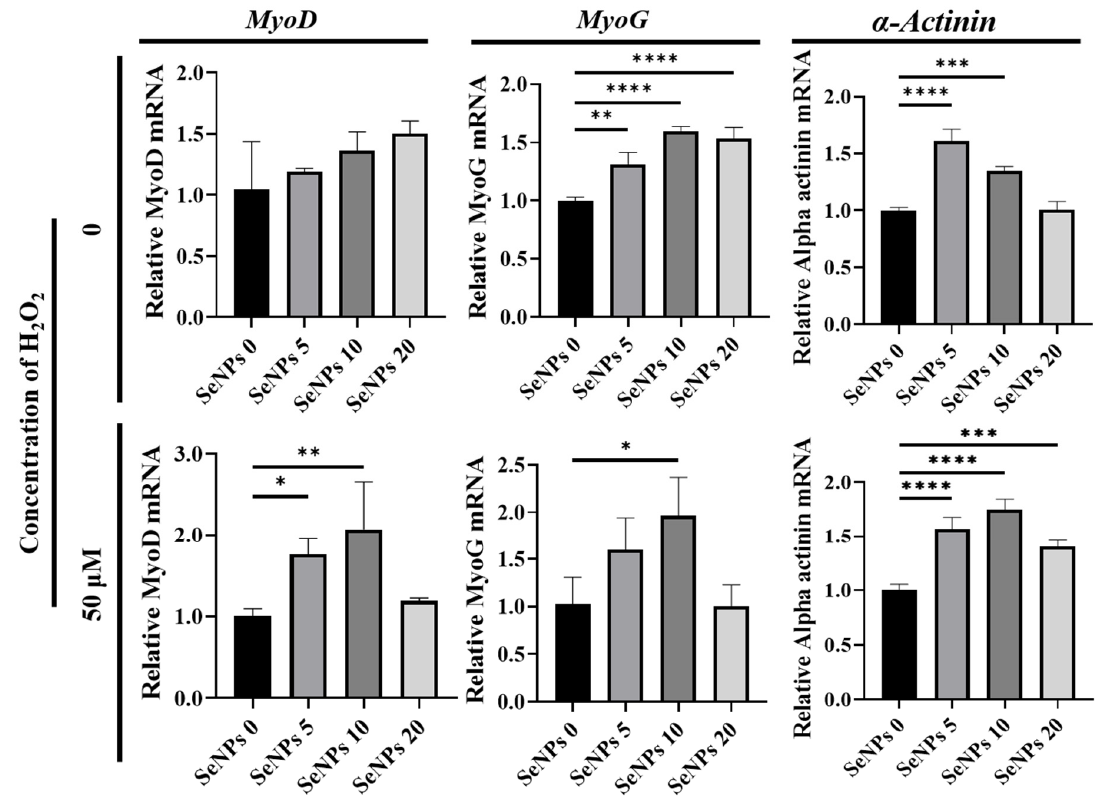
Figure 5. The effect of SeNPs on the expression of myogenic genes through qRT–PCR analysis. The relative expression levels of target genes normalized to Gapdh were calculated using the delta cycle threshold (Ct) method. The figure shows the relative expression of multiple genes relative to gene expression in the negative control treatment cells. The results of the qRT-PCR analysis of myogenic markers five days after treatment with myogenic differentiation media. In the group treated with selenium, the activities of MyoD , MyoG , and α -actinin were higher than those in the group not treated with selenium. Statistical significance was calculated using one-way ANOVA, followed by a two-sided Dunnett post hoc test compared to the untreated SeNPs group * Represents p < 0.05, ** p < 0.01, *** p < 0.001, and **** p < 0.0001; n = 3.